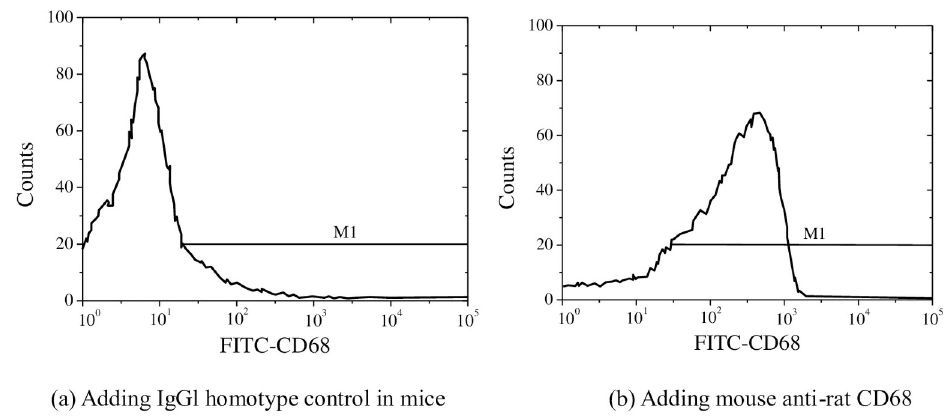
Fig 2. Purity identification of rat peritoneal macrophages.